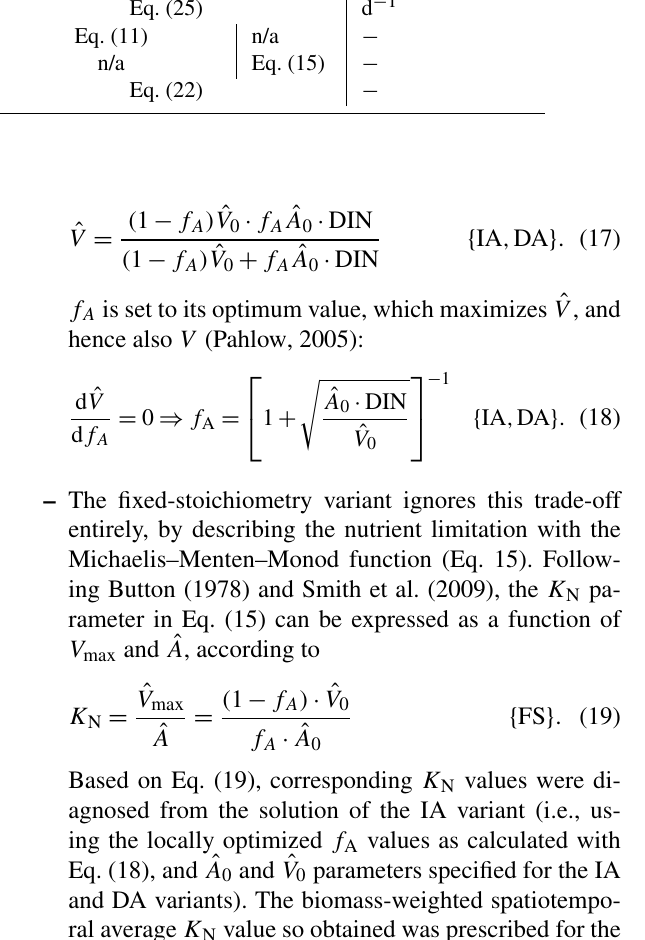
Table 2. Summary of differences between model variants. n/a denotes “not applicable”. ∗ Prescribed; see Table 3. Equation/definition Term Definition Units IA DA FS Phy C Carbon bound to phytoplankton Phy N /Q Eq. (1b) Phy N /Q mmolCm − 3 F DIN − Phy N flux from DIN to Phy N Eq. (5) mmolNm − 3 d − 1 N F DIC − Phy C flux from DIC to Phy N n/a Eq. (8) n/a mmolCm − 3 d − 1 C f V Fractional allocation to uptake Eq. (14) ∗ − V Specific N uptake rate Eq. (6) Eq. (12) Eq. (6) molNmolC − 1 d − 1 µ Cellular net growth rate Eq. (7) d − 1 µ g Cellular gross growth rate Eq. (13) d − 1 µ net µ g − R Chl Eq. (7) d − 1 ˆ µ g Gross growth rate within chloroplast Eq. (21) d − 1 ˆ µ g − ˆ R Chl Phy N / Phy C molNmolC − 1 molNmolC − 1 d − 1